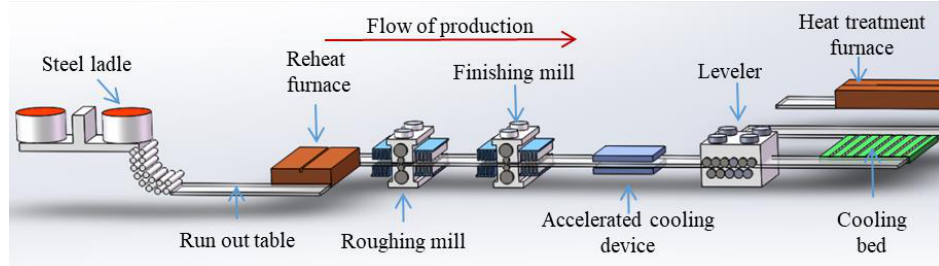
Figure 1. Diagram of steel plate production process [5].